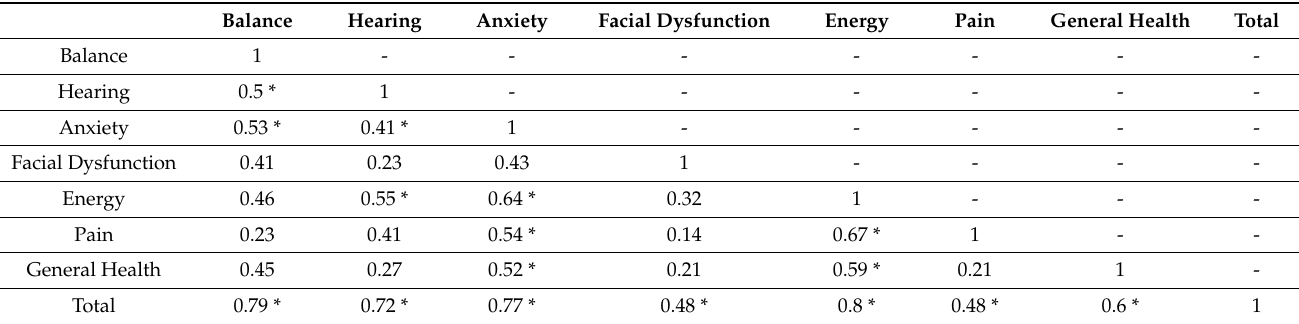
Table 5. Rho Spearman correlation matrix for PANQOL domains